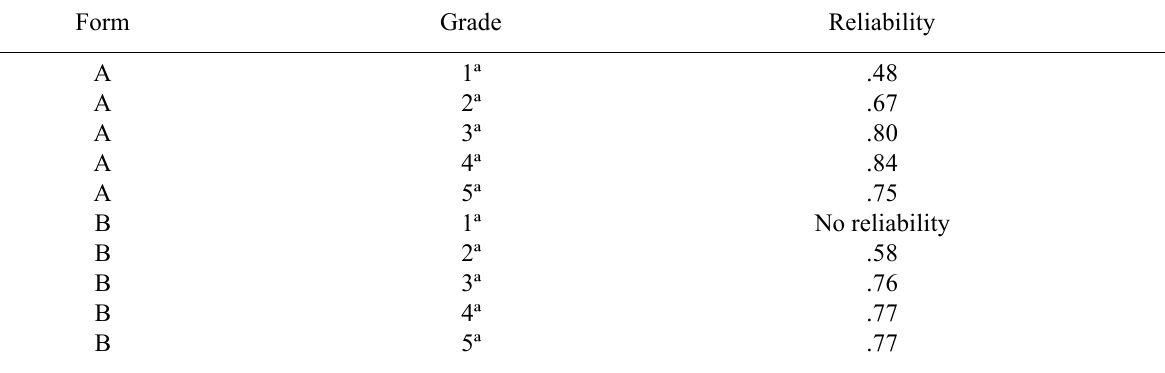
Reliability Index Evaluated for Form A and B by Grades Form Grade